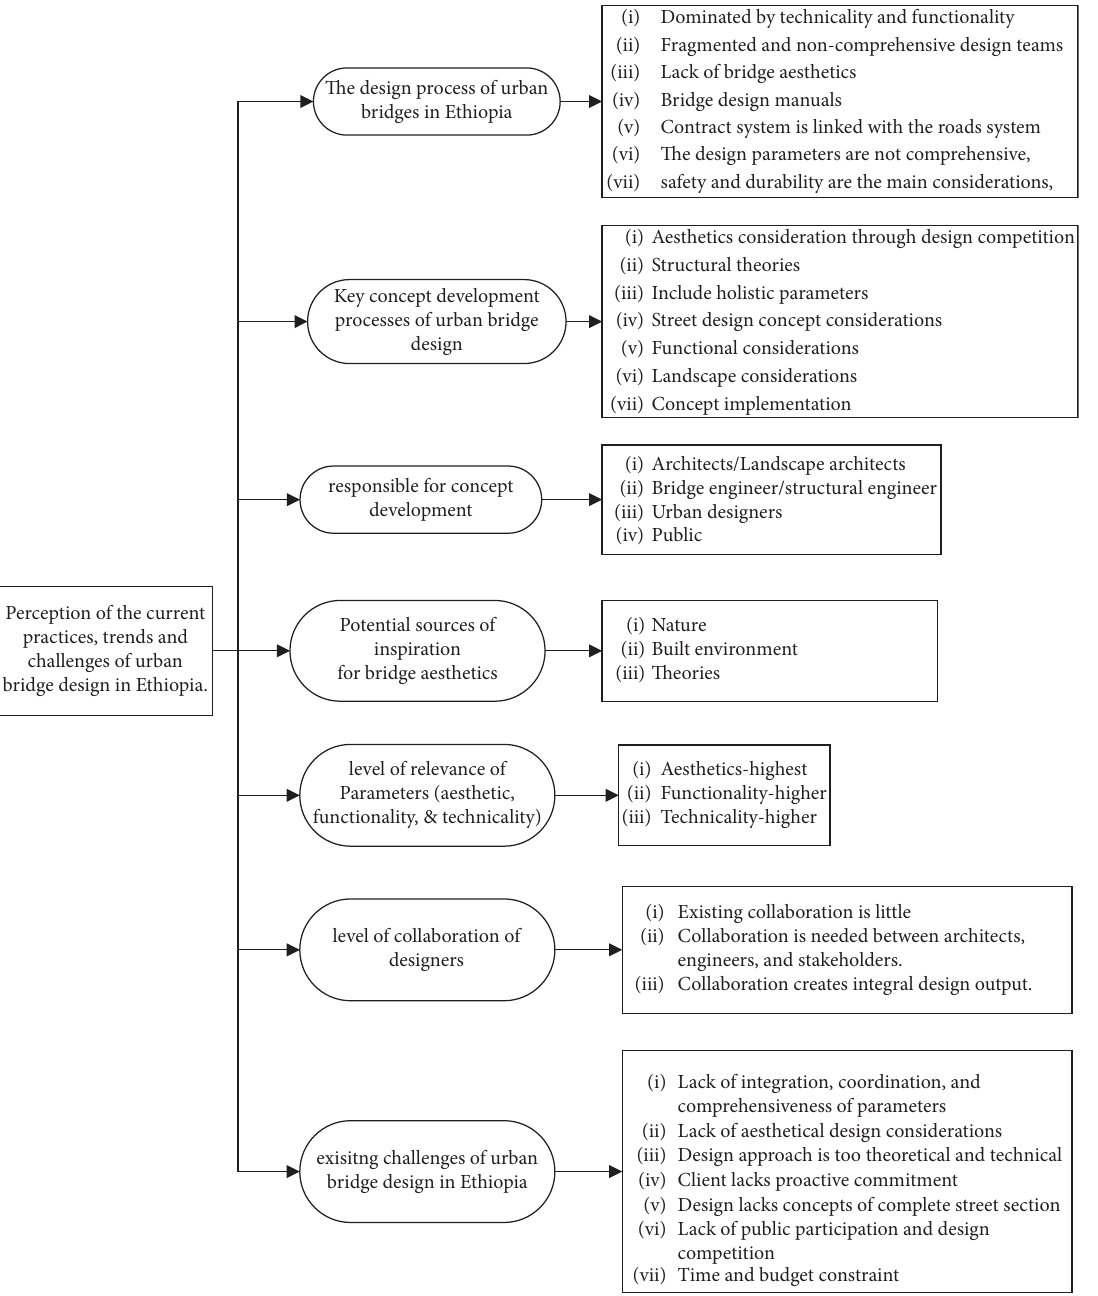
Figure 1: Trends of urban bridge design in